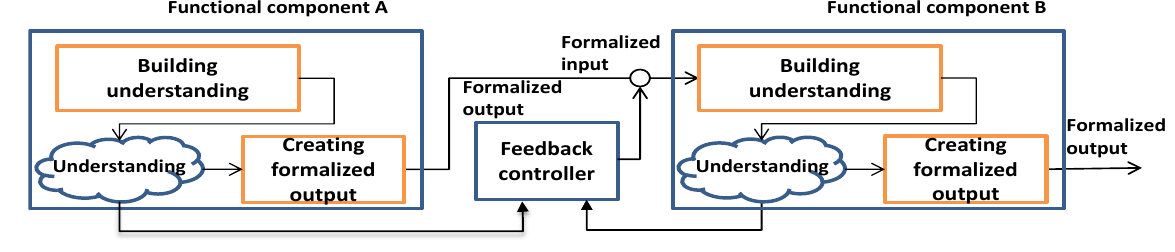
Figure 2. Negative feedback between two components of the